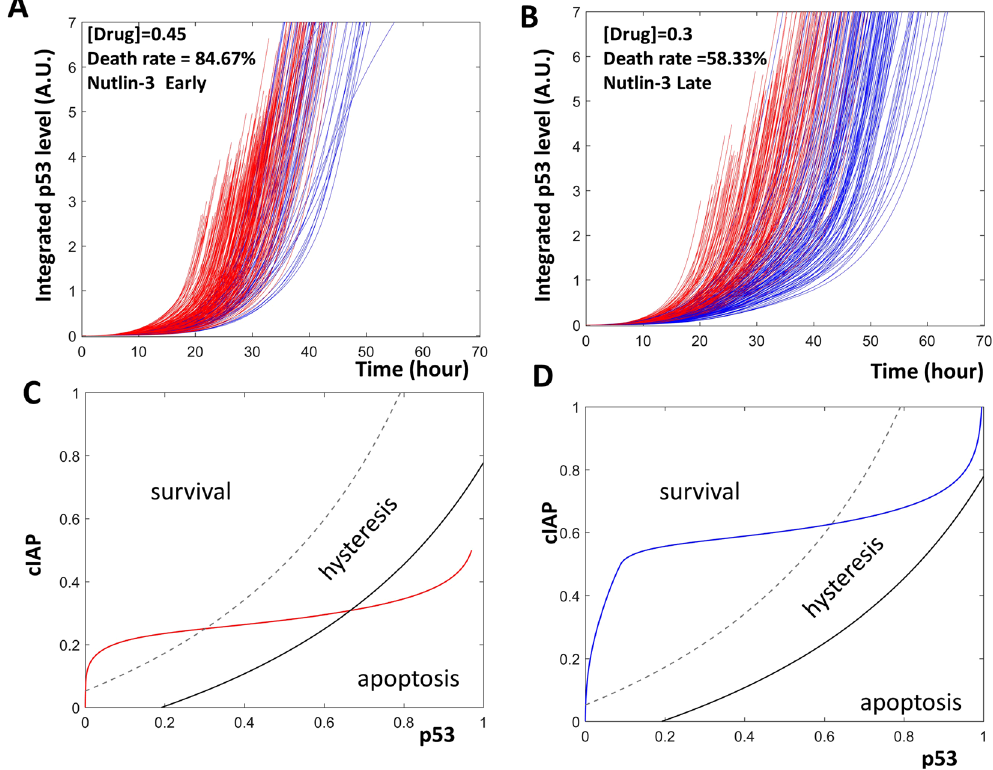
Figure 5. The timing of Nutlin addition controls cellular fates. ( A and B) The time series simulations. The green, black, blue, and red curves indicate Nutlin, p53, CIAP and BAXm, respectively. Early Nutlin addition triggers BAXm activation ( A ). A late addition of Nutlin does not trigger the activation of BAXm ( B ). ( C and D ) Two parameter bifurcation diagrams together with the temporal trajectories of the apoptotic or surviving cells. Nutlin addition does not change the bifurcation geometry of the cells. Rather, an early addition of Nutlin pushes the cell trajectory into the apoptosis area (red curve, C ), while a late Nutlin addition does not (blue curve, D